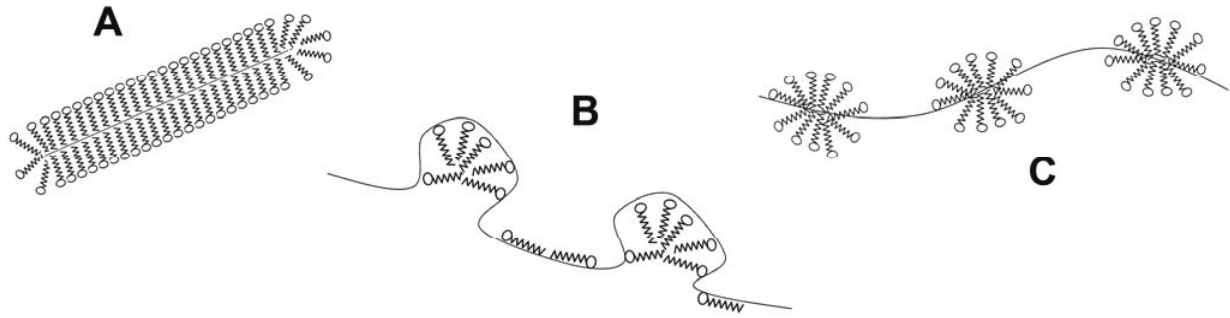
Figure 2. Structural models for protein-surfactant complexes. ( A ) Surfactant molecules cover the denatured protein chain forming a rod-like micelle; ( B ) Surfactant micelles are decorated by the denatured protein; ( C ) Micelles are formed along the denatured protein forming a pearl-necklace like